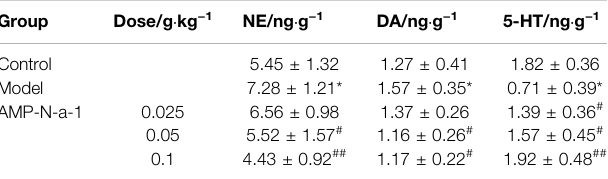
TABLE 3| Effects ofAMP-N-a-1 onNE, DA,and 5-HT contentsinthebraintissue of mice with learning and memory disorders ( n = 18, mean ± s). Group Dose/g · kg − 1